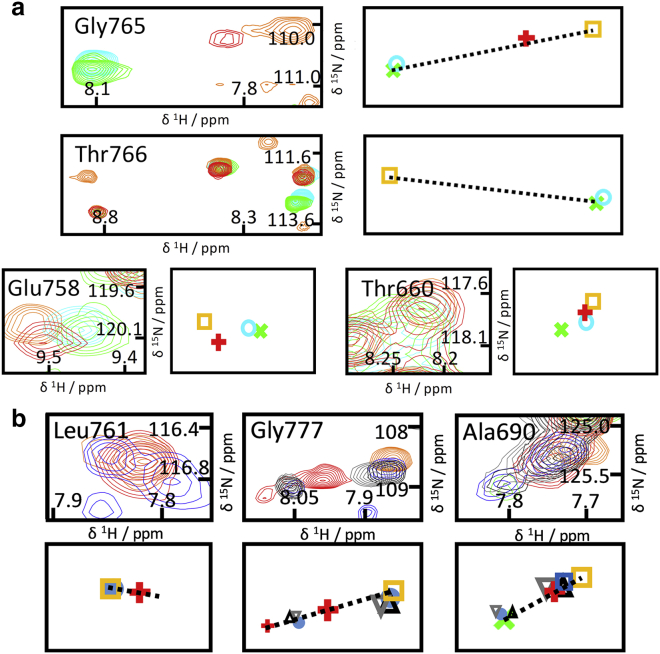
NMR evidence for a C-terminal-linker-dependent allosteric pathway connecting the Tyr783 phosphorylation site with the nSH2-cSH2 junction. (a and b) Superposition of 1H,15N-HSQC spectra is shown next to supporting schematic representations of crosspeak centroids ((a) 600 MHz, (b) 700 MHz, using the same color scheme as in Fig. 3; further examples are shown in Fig. S7). (a) For many extended C-terminus residues, only the crosspeaks for NSH2CSH2ΔCT and NSH2CSH2ΔCT-CTpY coincide, indicating a C-terminal-linker-dependent effect. Thr660 (nSH2-cSH2 junction) is affected by Tyr783 phosphorylation in part via the bridging C-terminal linker. (b) The crosspeaks for the residues shown are shifted toward the “closed” state when the nSH2 domain is absent (CSH2) or when the nSH2-cSH2 junction is mutated, consistent with allosteric communication via the extended C-terminus.